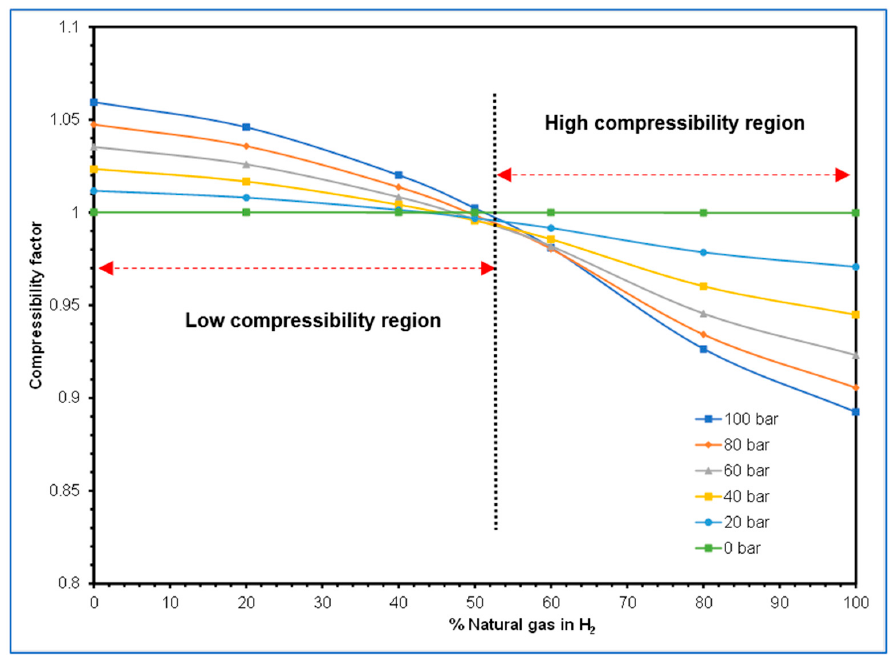
Figure 9. Compressibility behaviour of hydrogen blends.